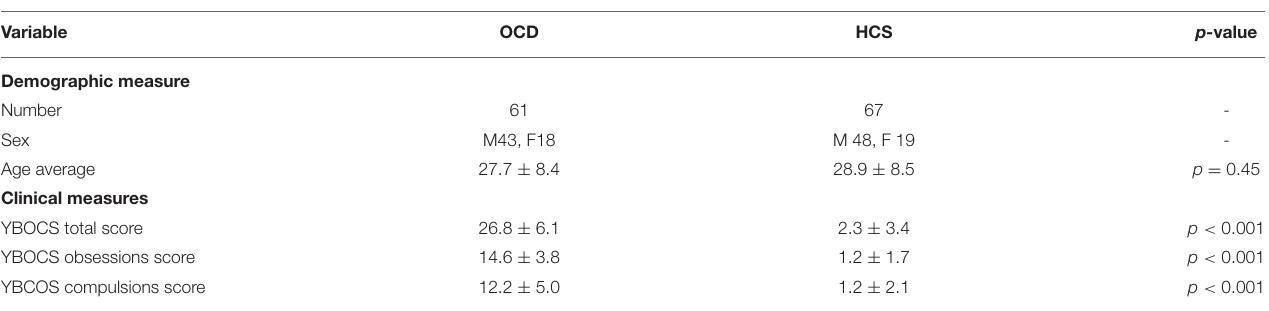
TABLE 1 | Demographic and clinical characteristics of the